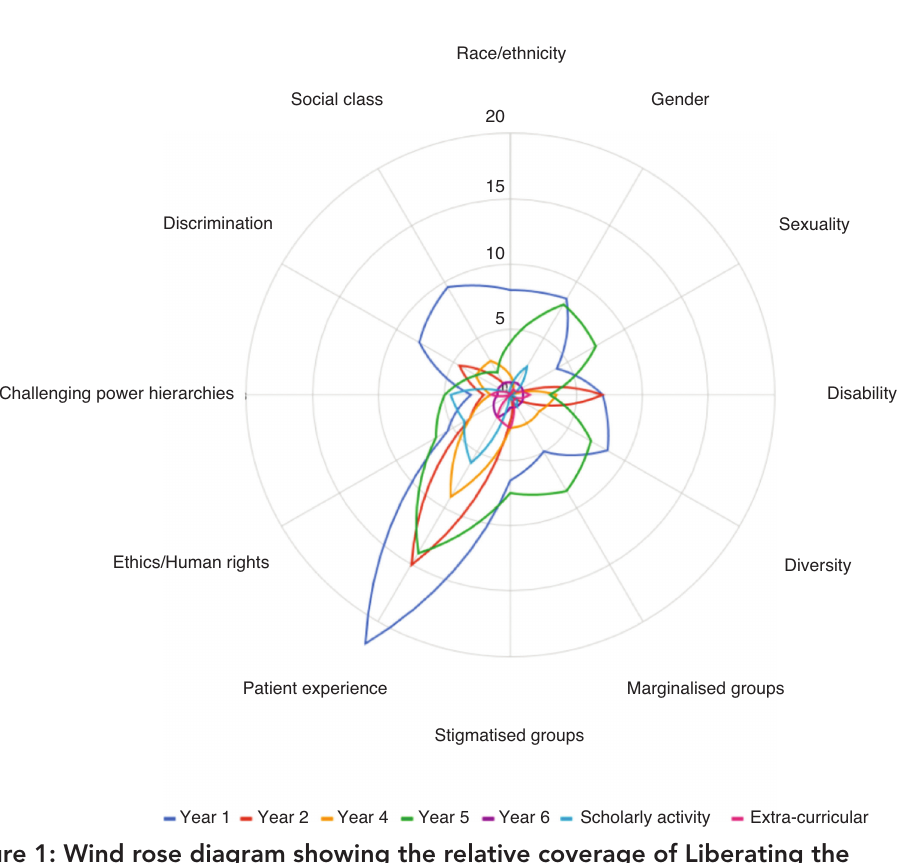
Figure 1: Wind rose diagram showing the relative coverage of Liberating the Curriculum themes across years (Source: Authors,